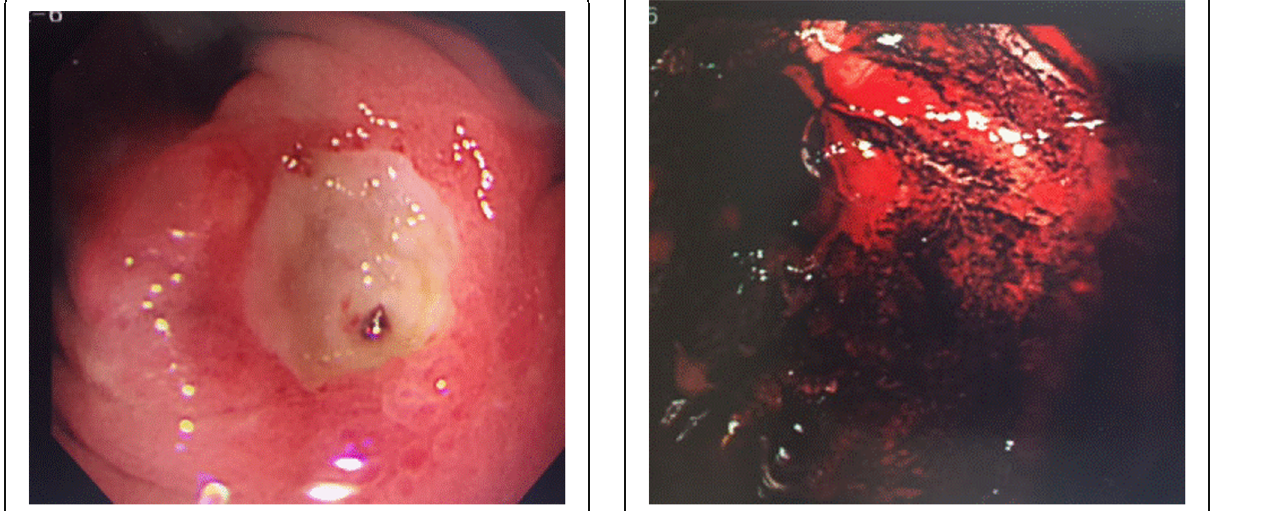
Fig. 1 Marginal ulcer in the jejunal pouch was detected by upper gastrointestinalendoscopy